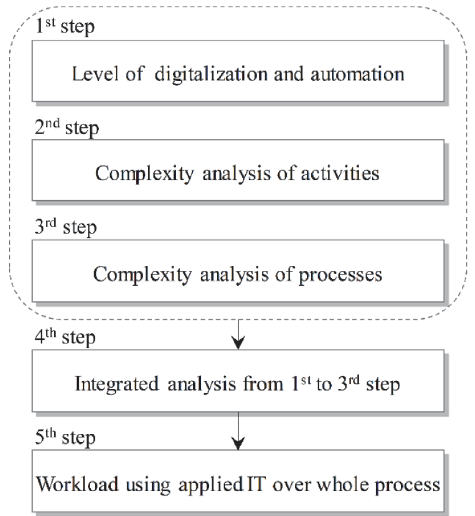
Figure 3. The proposed method for analyzing the effect of